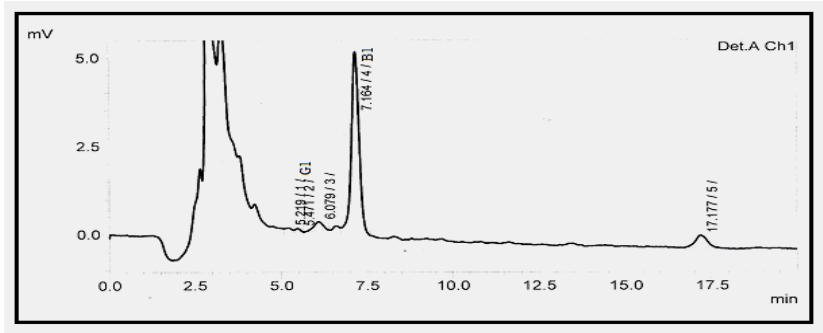
Figure 4. Chromatogram showing high level of AFB1 in gram